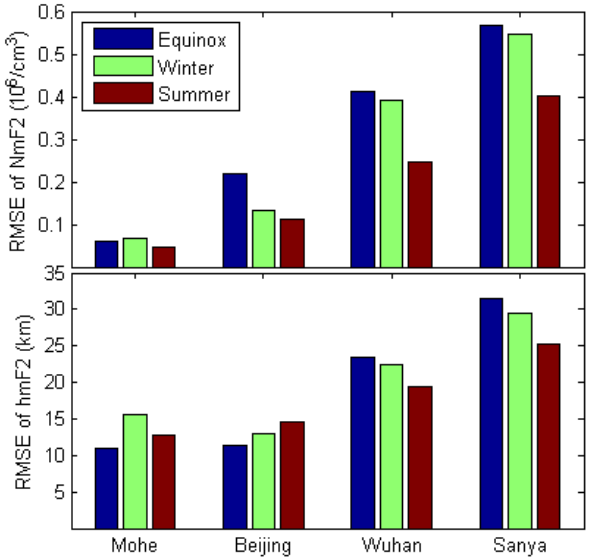
Figure 7. Root mean square errors of Nm F2 and hm F2 from COS- MIC and ionosonde measurements in the equinox, winter and sum- mer periods.